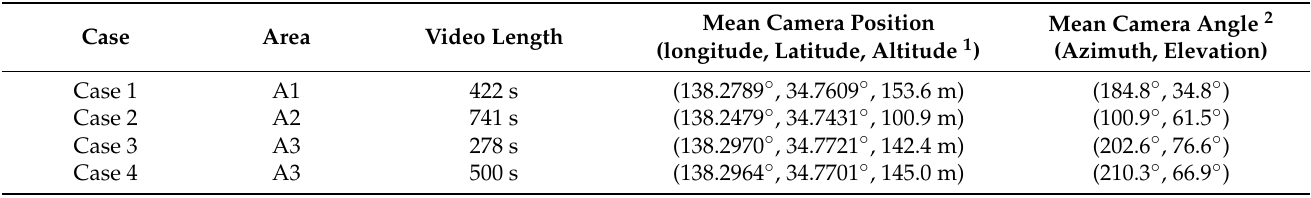
Table 2. Video length and estimated camera